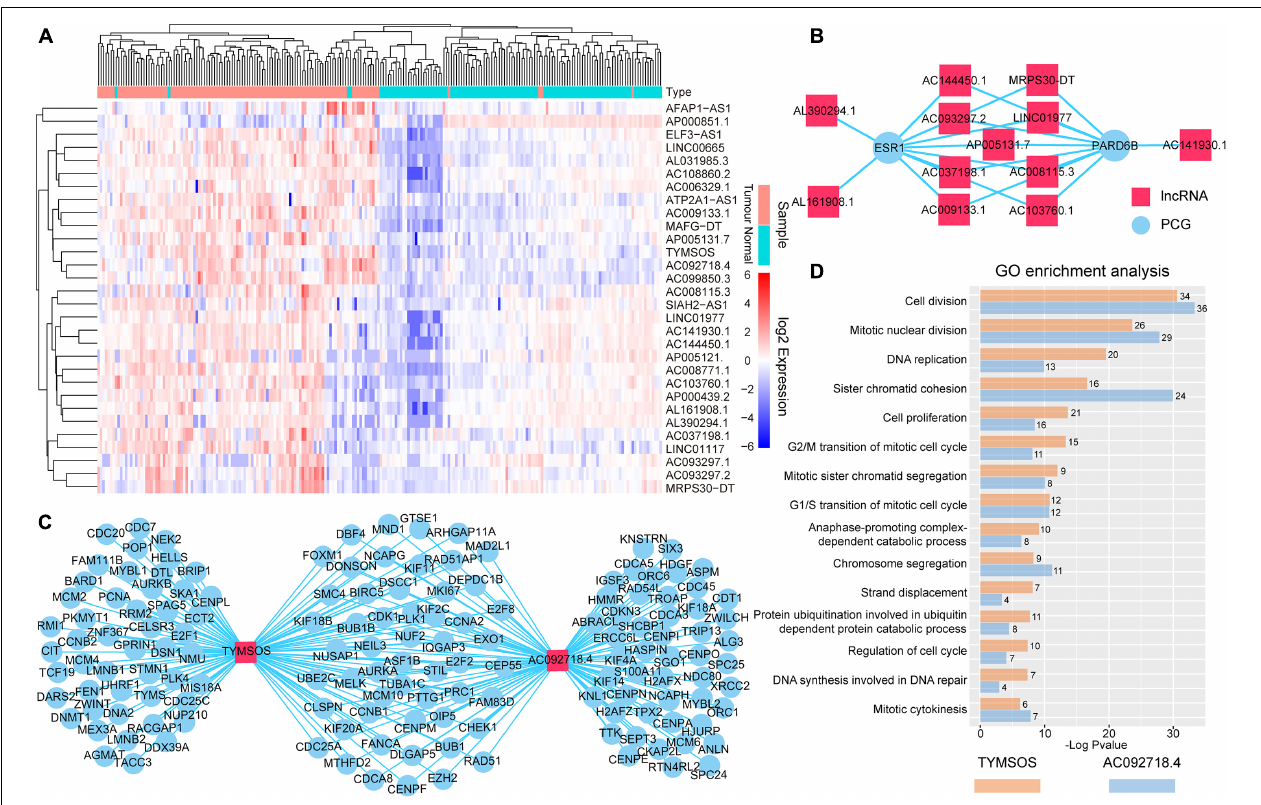
FIGURE 3 | Analysis of the identified risk lncRNAs. (A) The heatmap of 30 risk lncRNAs based on their expression. The columns represented 224 samples of 112 BRCA patients, and the rows represented lncRNAs. The risk lncRNAs classified the samples into tumor tissue and adjacent nontumor tissue. (B) Top two PCGs with high lncRNA interactive relationships. Red nodes represent lncRNAs, and blue nodes represent PCGs. (C) Top two risk lncRNAs with high PCG interactive relationships. (D) GO enrichment analysis for lncRNAs TYMSOS and AC092718.4 through their related PCGs, respectively. The X -axis shows the –log10 of the P -value; the Y -axis shows the names of the GO term. The number at the top of the bar indicates the number of PCGs annotated to the GO